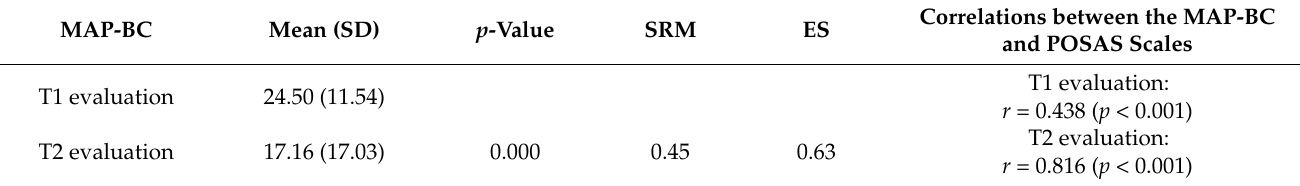
Table 2. Validity and responsiveness of the MAP-BC Spanish